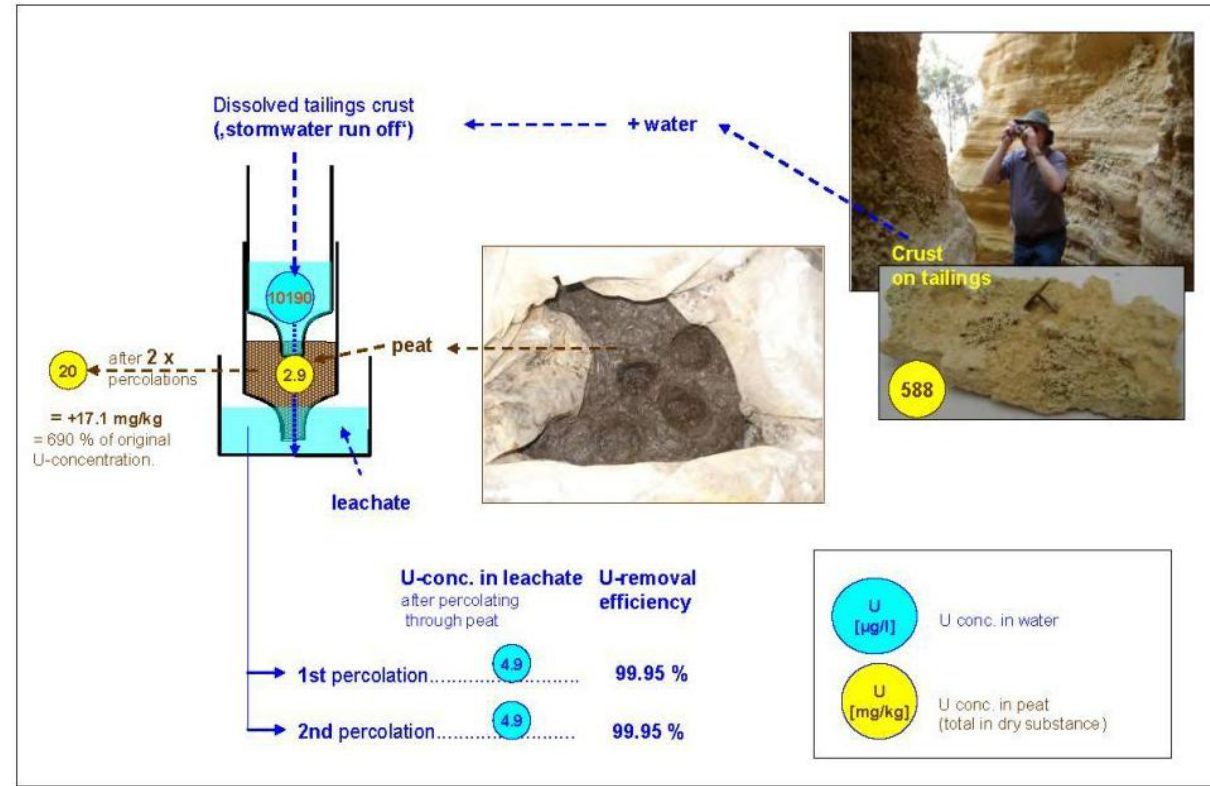
Figure 17. Removal efficiency of peat from the GMB wetland for U contained in (simulated) tailings